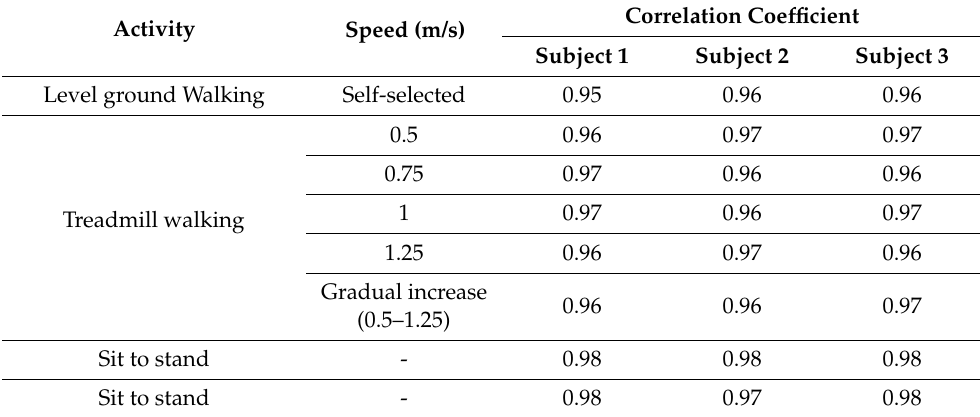
Table 3. The summary of Knee angle measurement comparison (exoskeleton vs. Vicon).